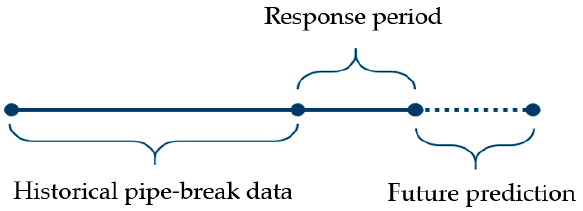
Figure 3. Schematic of pipe failure prediction by Random Forest.